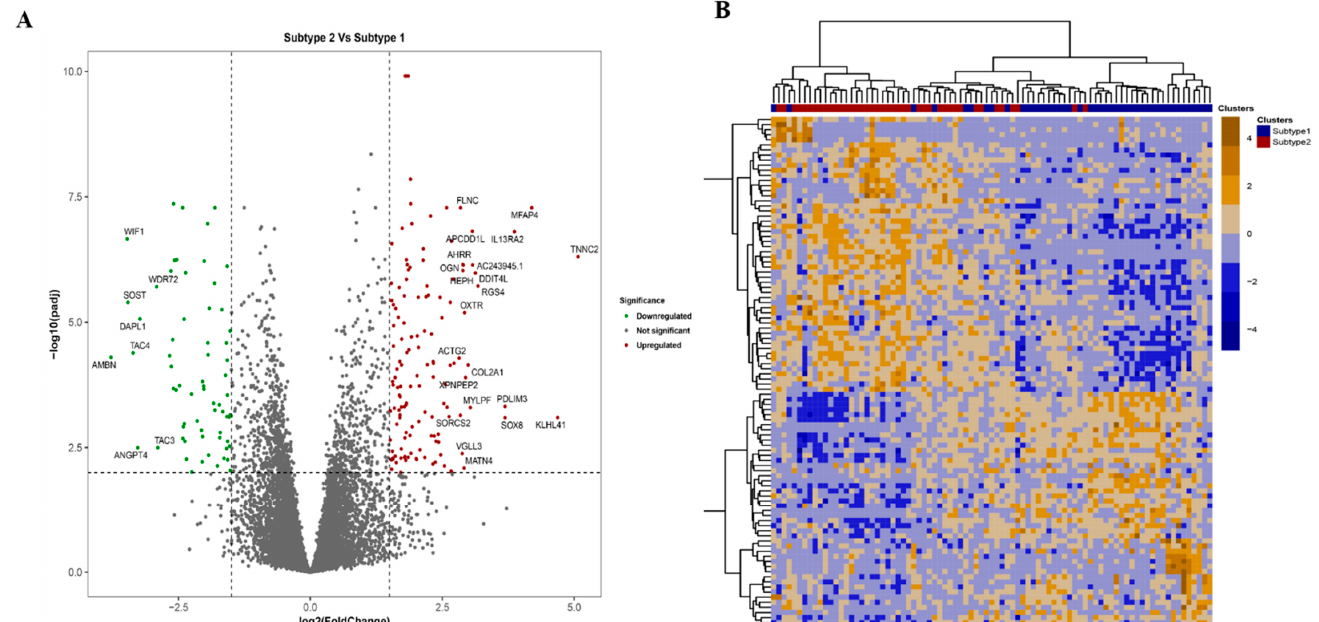
Figure 5. ( A ) Volcano plot showing the di ff erentially expressed genes between the two molecular subtypes. The downregulated (green) and upregulated (red) genes obtained at abs(log 2 Fold Change) > 1.5 and adjusted p -value < 0.05 are highlighted. ( B ) Heatmap showing top 100 most variable di ff erentially expressed genes obtained at abs(log 2 Fold Change) > 1 and adjusted p -value < 0.01 cuto ff found between the two molecular clusters.